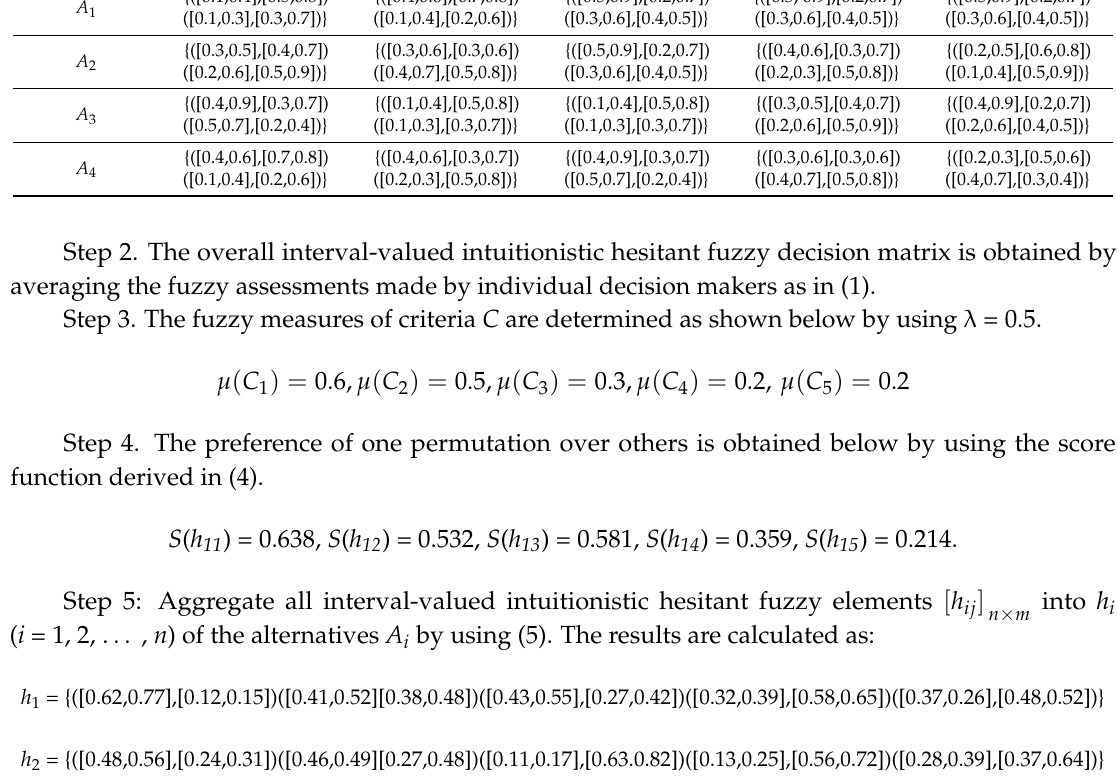
Table 3. The interval-valued intuitionistic hesitant fuzzy decision matrix for decision maker 3. Alternatives C